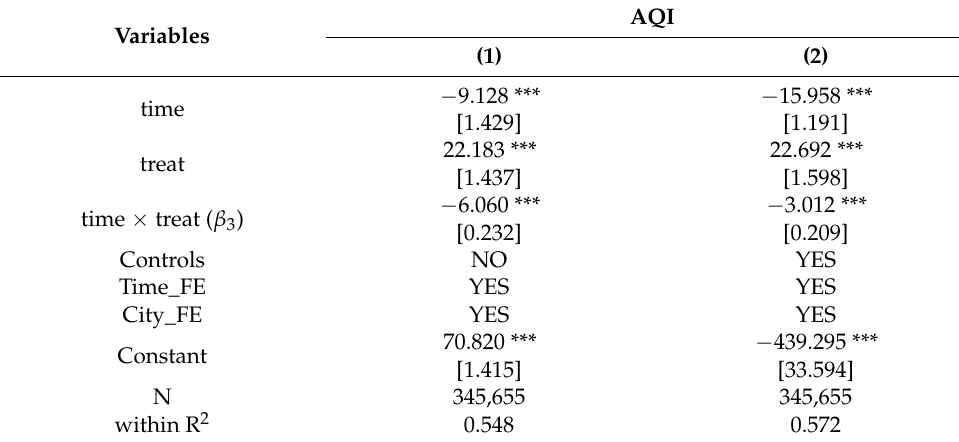
Table A2. Estimation results of the BSDW policy on